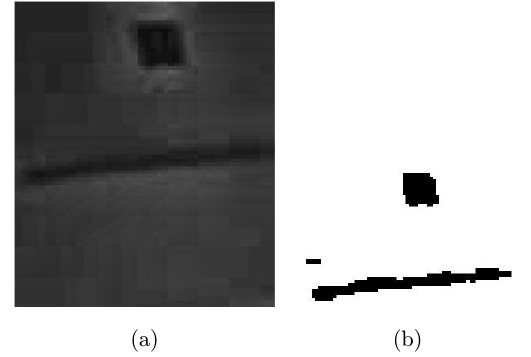
Fig. 10. In-vitro measurement results; (a) gelatin phantom image, (b) processed vascular (tube) image (small square region denotes reference scaling object).